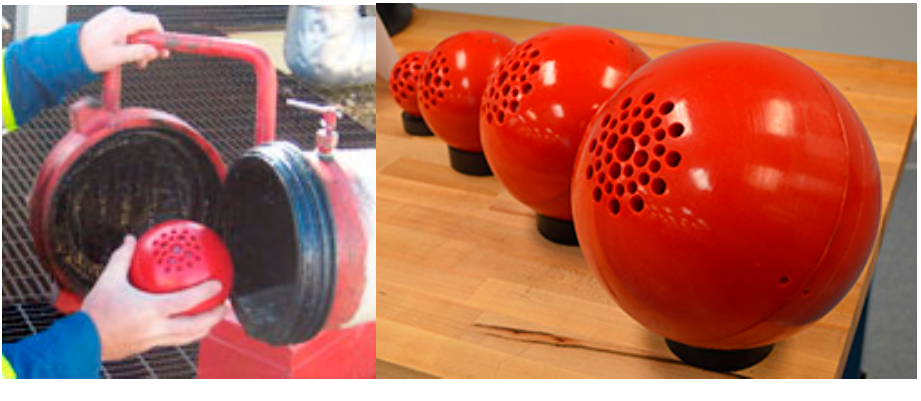
Figure 4. Pure Technologies, Ltd. (Calgary, Alberta) Smart-Ball. (Reproduced with permission from ref. [130]. Copyright 2021 American Society of Mechanical Engineers ASME).